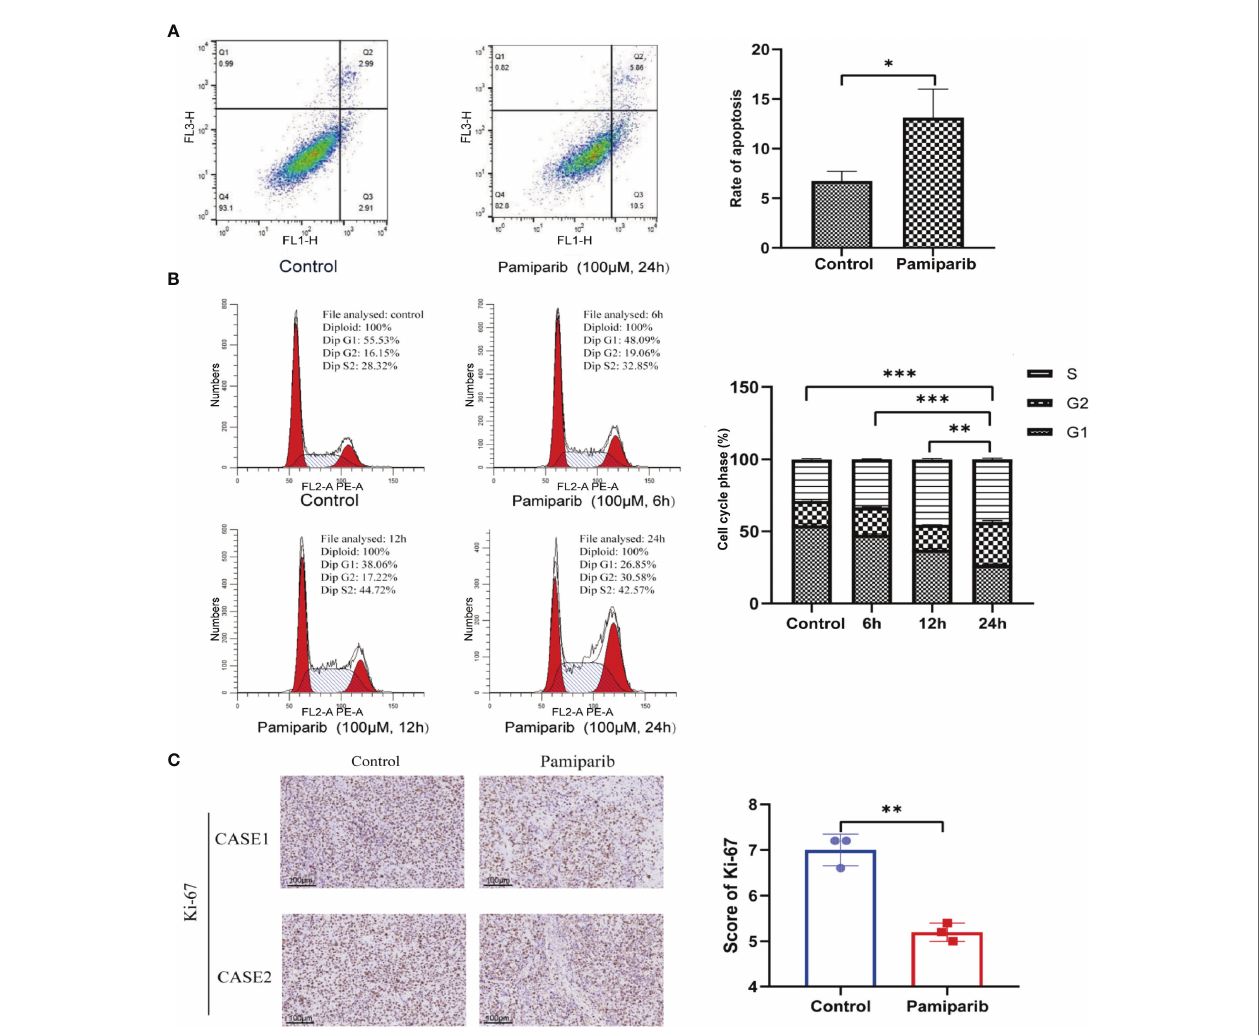
FIGURE 1 | Pamiparib affects apoptosis, cell cycle, and proliferation in pancreatic cancer cells. (A) Flow cytometry detection of cell apoptosis showing pamiparib treatment causes a signi fi cant increase of apoptosis in SW1990 cells. (B) Flow cytometry detection of cell cycle showing pamiparib blocks SW1990 cells in G2/M phase. (C) IHC staining of Ki-67 showing pamiparib inhibits the proliferation of SW1990 cells in the in vivo environment. Data are mean ± SD; n = 3 samples per group. Scale bar, 100 m m. The IHC results were analyzed by Pearson c 2 test. * P < 0.05, ** P < 0.01, *** P <